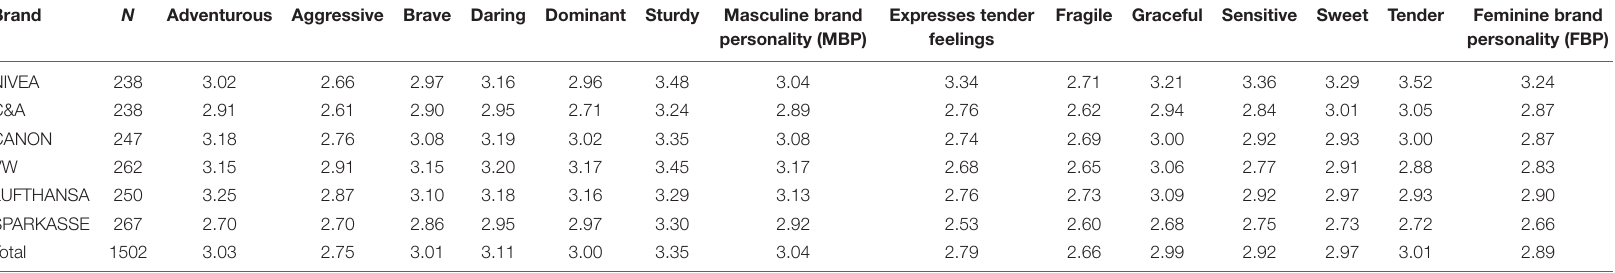
Expresses tender personality (MBP) feelings